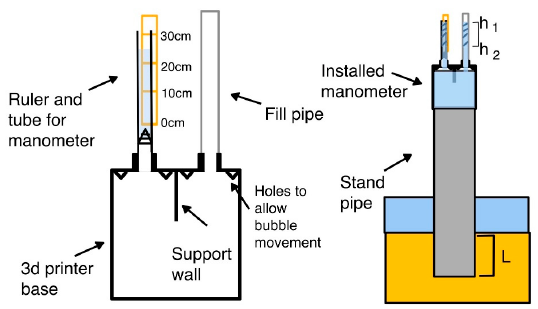
Figure 6. In situ standing head manometer setup deployed in the SOVI